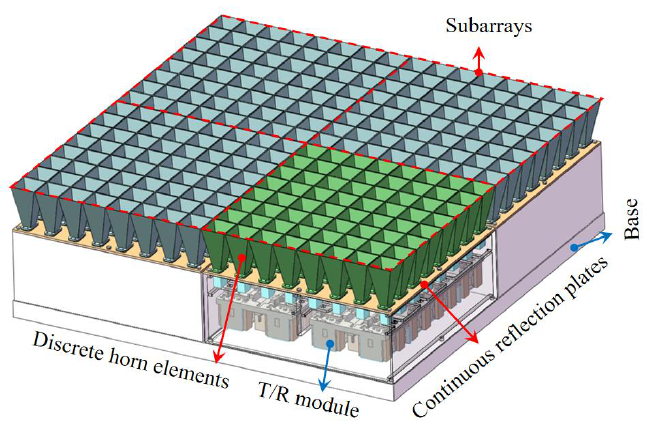
Figure 1. The computer-aided design (CAD) model of a planar phased array antenna.